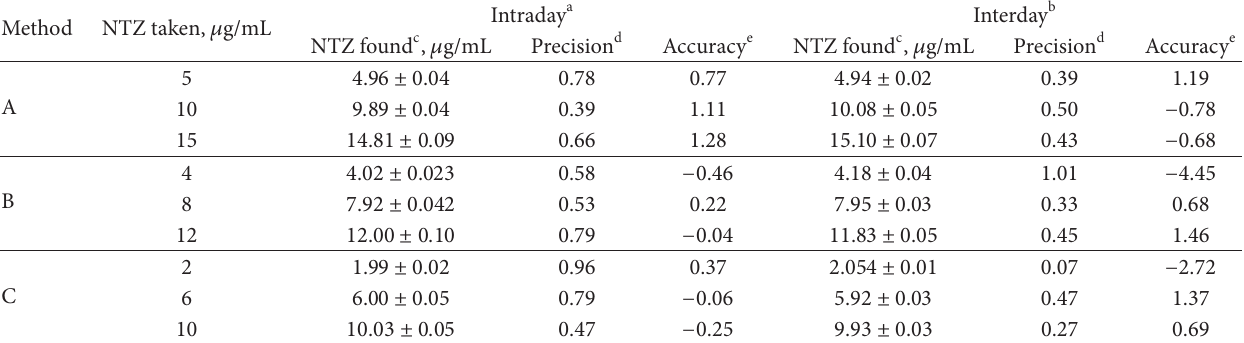
T 2: Evaluation of intraday and interday accuracy and precision results.